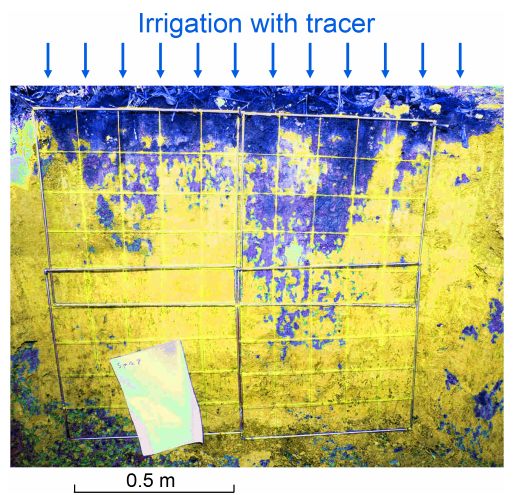
Figure 3. Preferential infiltration. Dye flow patterns observed at the Weiherbach irrigation site, Germany. From Zehe et al. (2007).